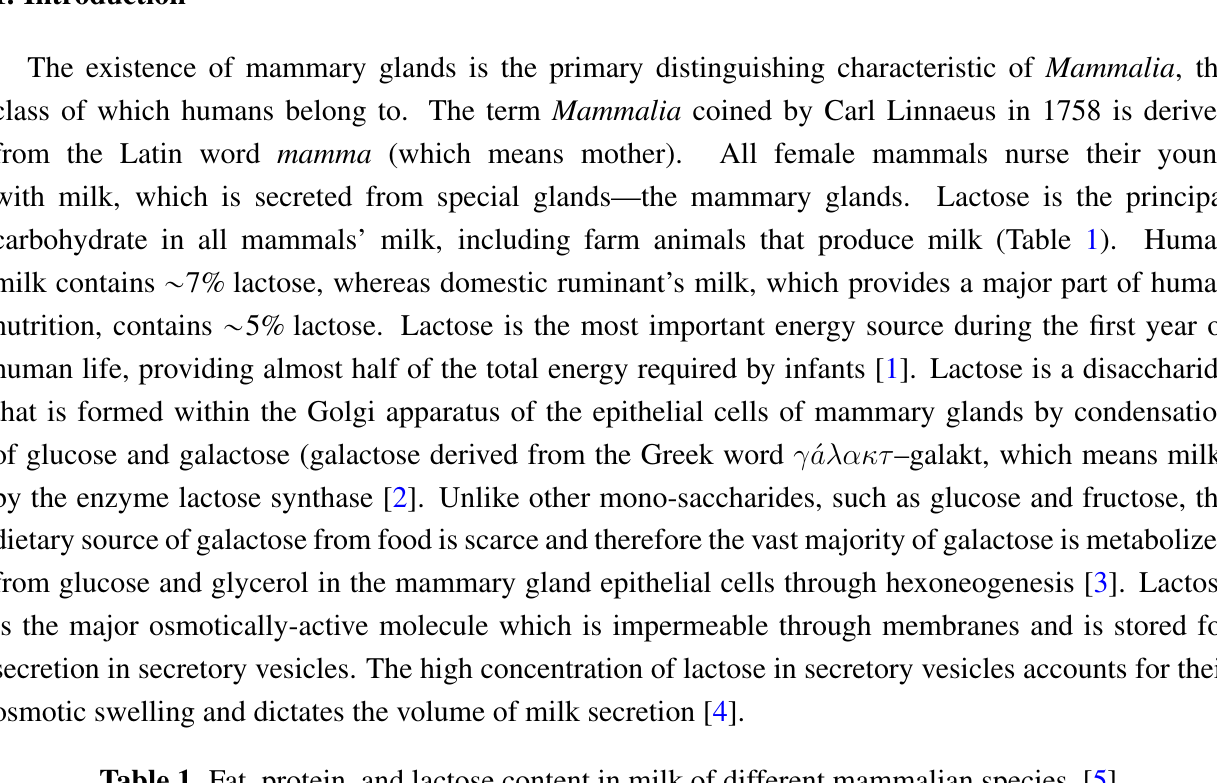
Table 1. Fat, protein, and lactose content in milk of different mammalian species